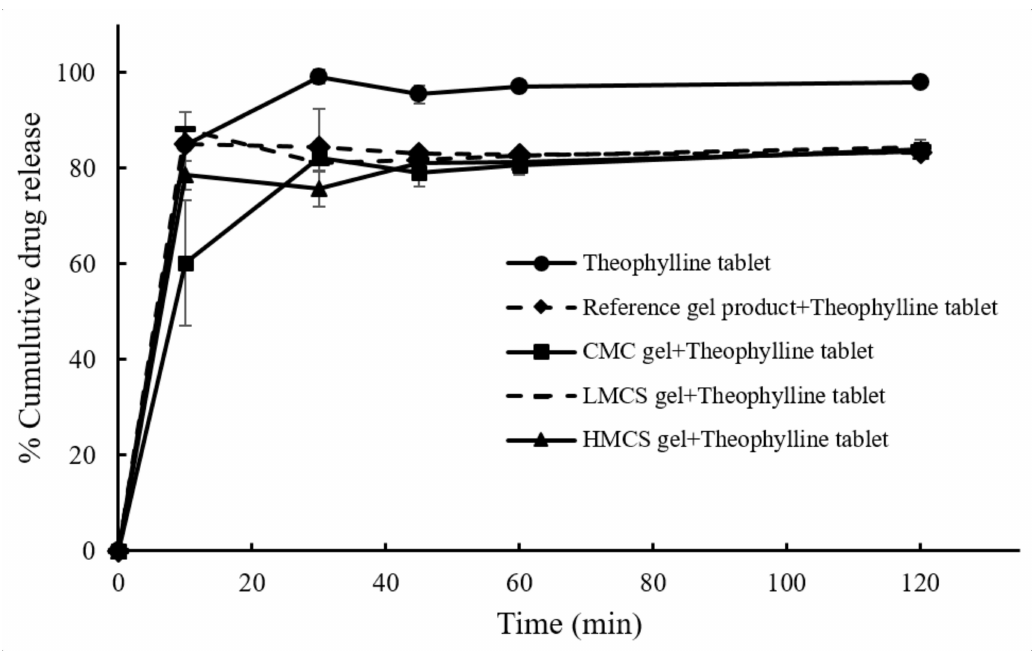
Figure 9. Dissolution profiles of the theophylline tablets and the tablet covered with different pill swallowing gel formulations. Table 2. f 1 (similarity factor) and f 2 (dissimilarity factor) of the theophylline tablets covered with several gel type compared with the plain